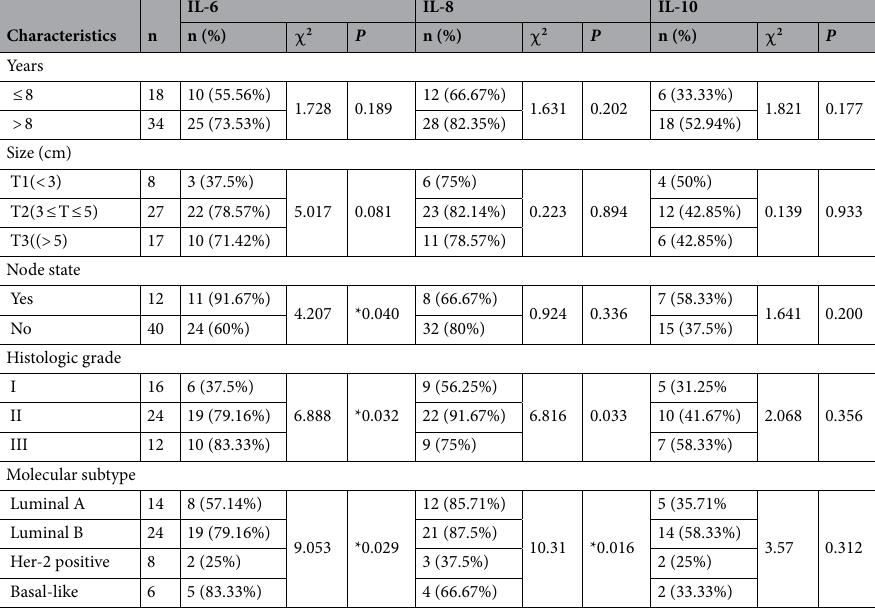
Table 4. Relationship between the expression of IL-6, IL-8, IL-10 protein and clinicopathological factors in malignant CMGTs tissue. * P < 0.05 was considered to be statistically